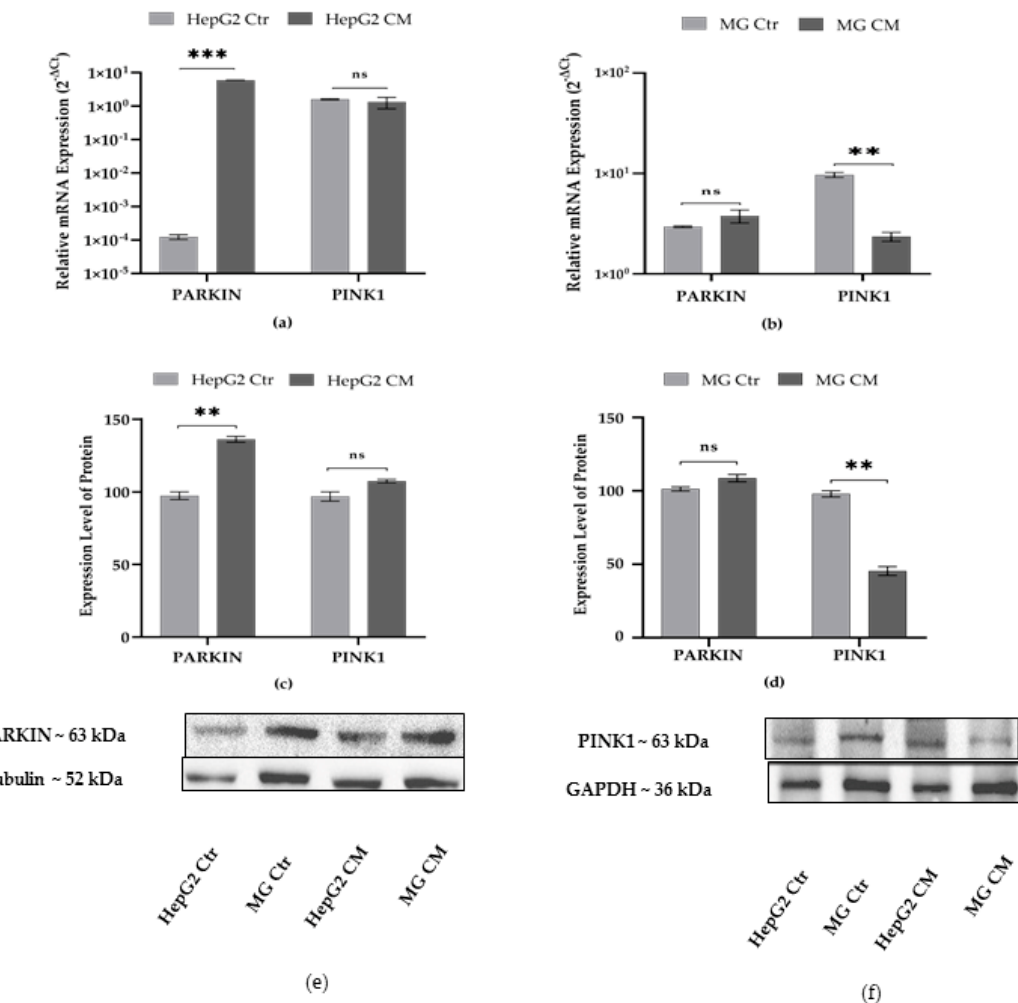
Figure 3. Effect of conditioned media on expression levels of PARKIN and PINK1. Transcript levels in ( a ) HepG2 and ( b ) HMC-III (MG) cells are expressed as 2 −Δ Ct and presented as the mean ± SEM of at least three different experiments. The protein expression level in ( c ) HepG2, ( d ) MG cells; ( e , f ) are representative western blots. The protein levels were normalized with GAPDH or Tubulin content; then, for each cell type grown in conditioned medium (CM), data refer to the corresponding control cells grown in their own culture medium (Ctr), set to 100%. Results are expressed as the mean ± the standard error of three independent experiments. Statistical analysis was performed by using t -test; ** p <0.01, *** p <0.001, control (Ctr) cells vs. media conditioned treated (CM) cells; ns: not significant p -value.